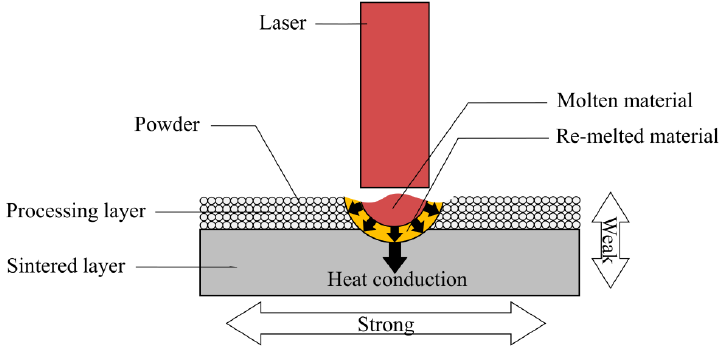
Figure 11. Illustration of selective laser sintering (SLS) processing.